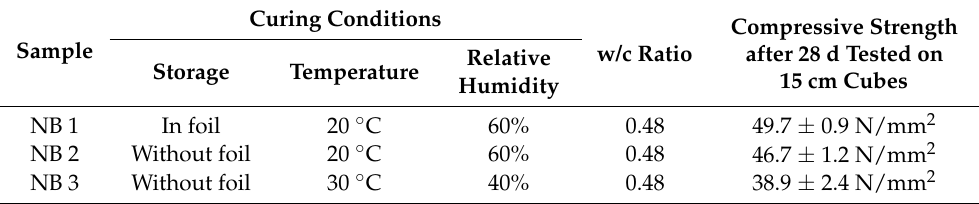
Table 3. Properties and curing conditions of the